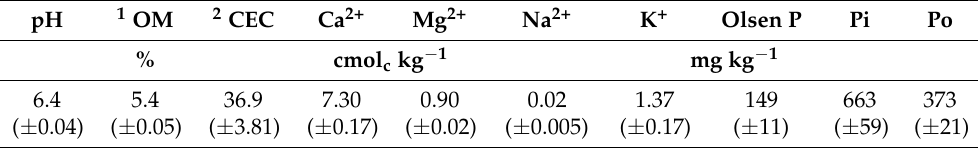
Table 4. Background soil properties (February 2020, n = 3, average ± SD).